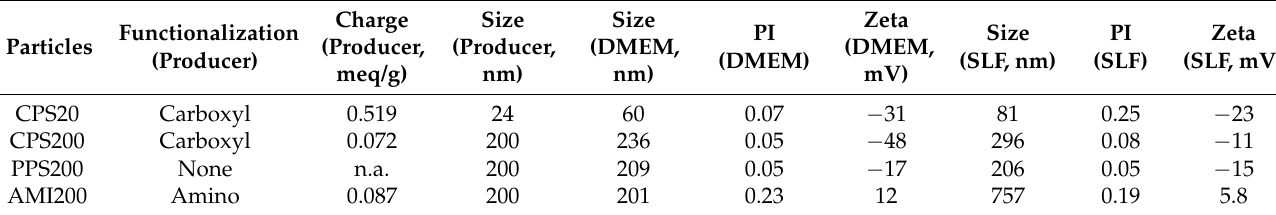
Table 2. Particle properties according to producer (functional groups, charge density, size) and hydrodynamic sizes, polydispersity index (PI) and zeta potential of the particles when suspended in cell culture medium (Dulbecco’s modified Eagle’s medium (DMEM) w/o fetal bovine serum (FBS)) and simulated lung fluid (SLF) (PBS + 0.02% dipalmitoylphos- phatidylcholine (DPPC)).